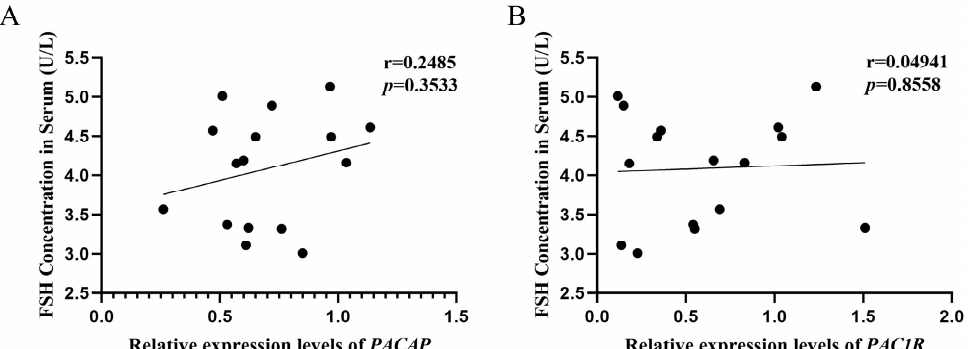
Figure 8. Correlation analysis between the PACAP/PAC1R expression and serum FSH concentration in Phodopus sungorus . ( A ) Correlation analysis between PACAP expression and serum FSH concentration. ( B ) Correlation analysis between PAC1R expression and serum FSH concentration. p < 0.05 represents significant difference.